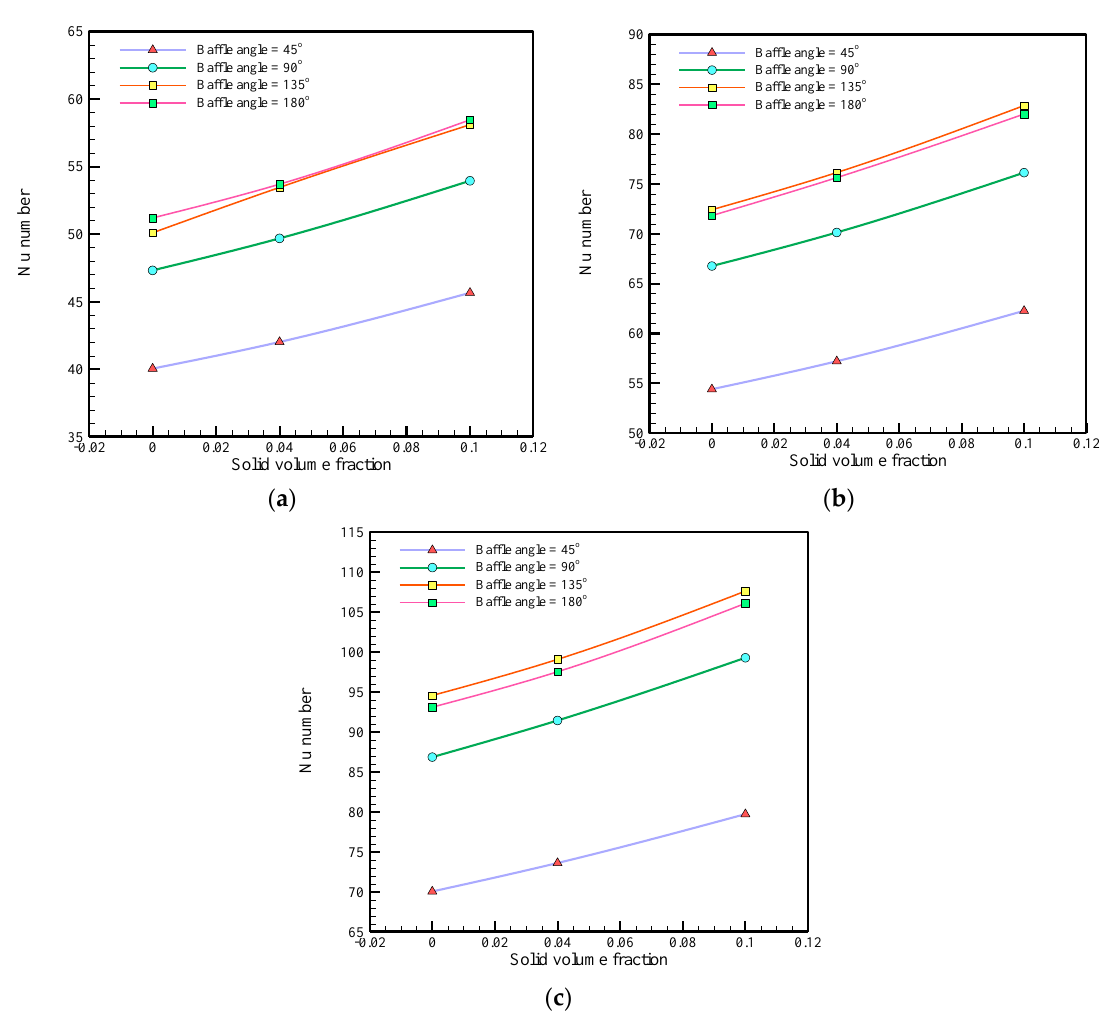
Figure 10. Nusselt number against solid volume fraction at various baffle angles with Reynolds numbers of ( a ) 10,000, ( b ) 15,000, and ( c ) 20,000.